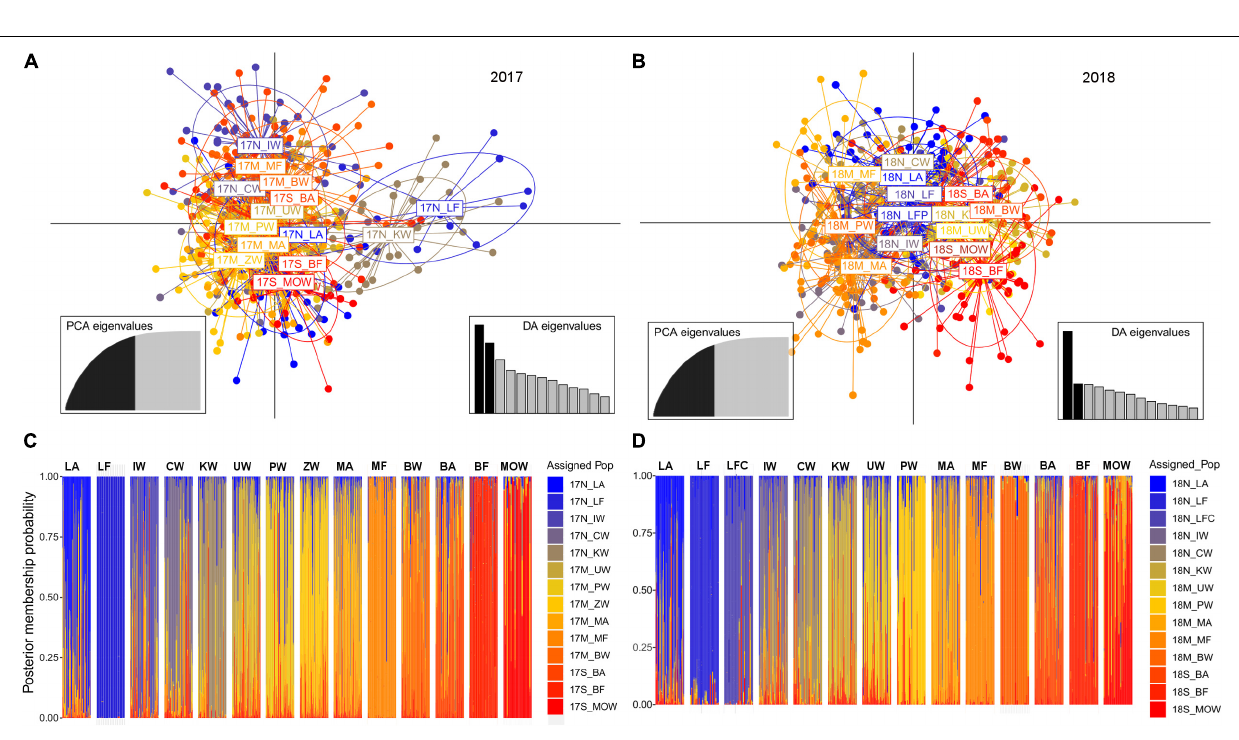
Frontiers in Marine Science | www.frontiersin.org